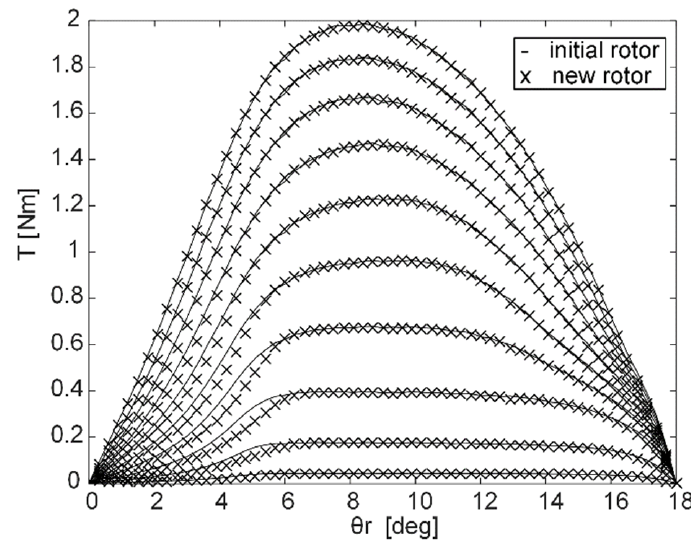
Figure 26. Static torque curves for initial and modified rotor designs.